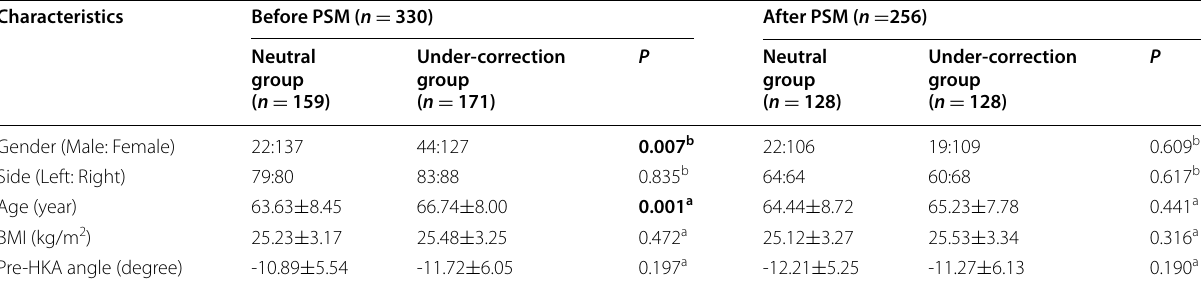
PSM propensity score matching, BMI body mass index, HKA hip-knee-ankle, For HKA angle, varus was negative and valgus was positive a stands for student t -test b stands for chi-square test; data are recorded as number or mean Table 2 Comparison of the between‑group postoperative alignment and components position at 2‑year follow‑up